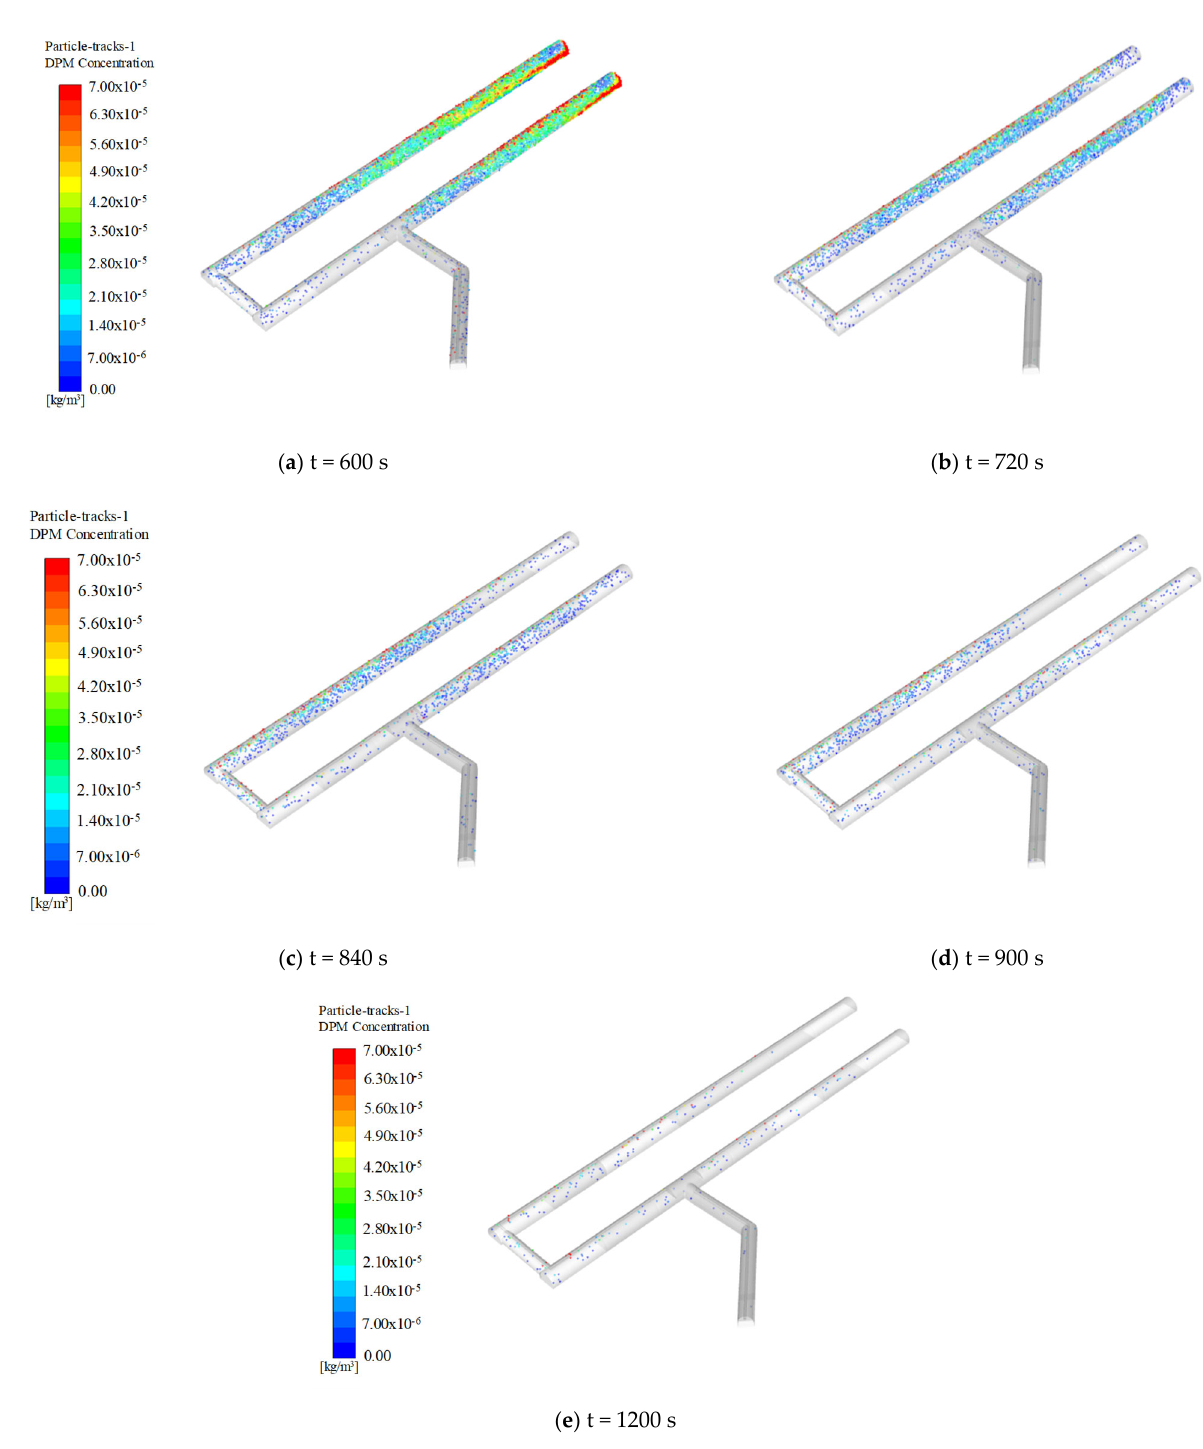
Figure 17. Dust distribution under the air cabin ventilation system.